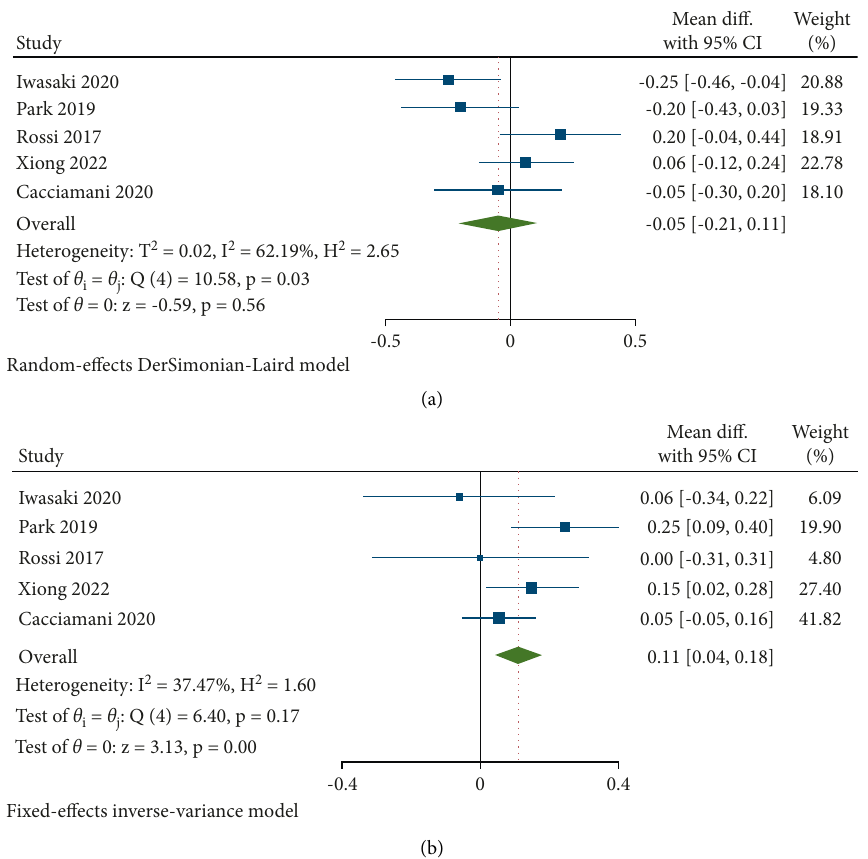
Figure 3: Forest plot of BCVA of ILM flap covering technique versus ILM flap filling technique. (a) Preoperative BCVA in logMAR. (b) Postoperative BCVA in